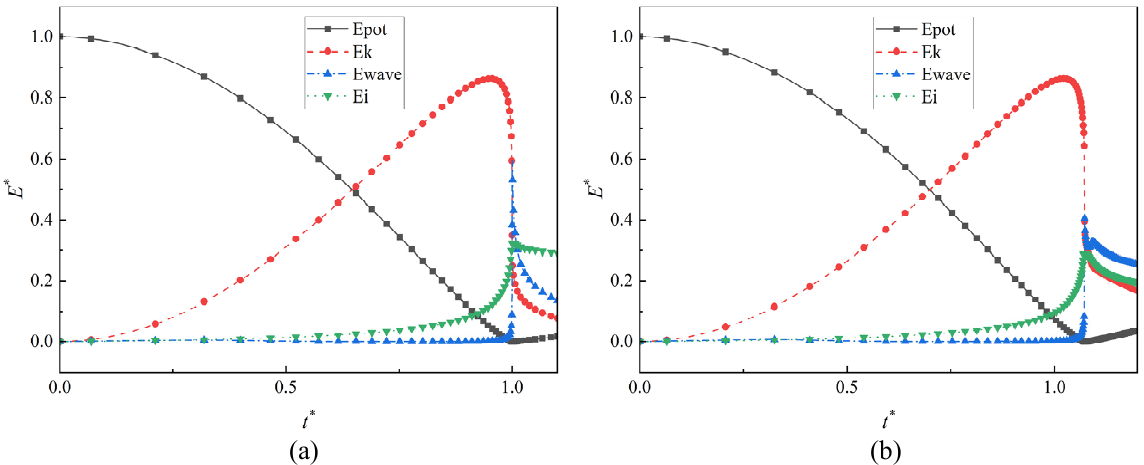
Figure 11. Time histories of the energy components of the bubble system. ( a ) Bubble collapse in the far-field region; ( b ) bubble collapse near the wall, γ = 2.5.